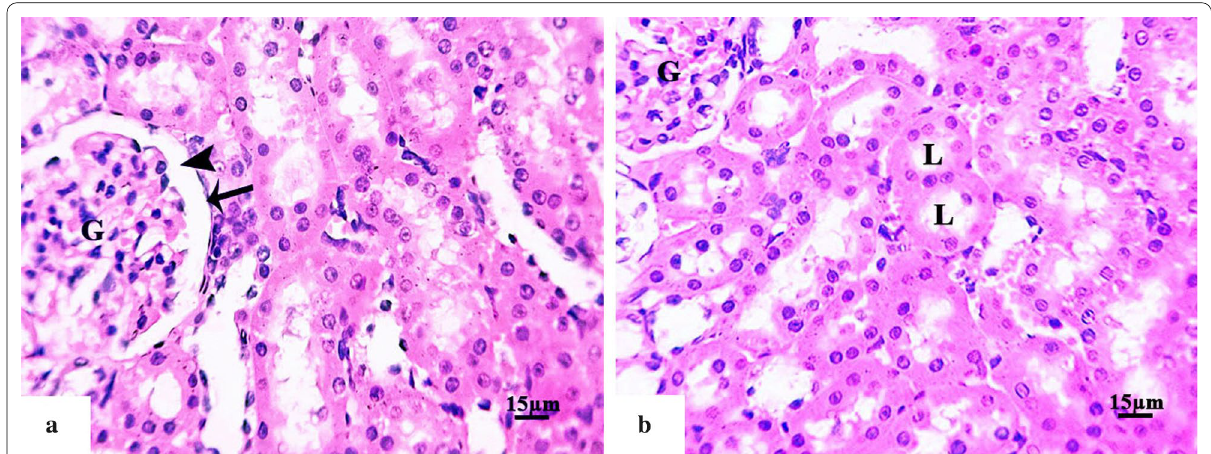
Fig. 3 a, b Photomicrographs obtained from kidney sections of sofo- and MO oil-treated rats showing mostly normal Bowman’s capsule (arrow), urinary space (arrowhead), glomeruli (G) and renal tubules with normal lumens (L), (H&E, X